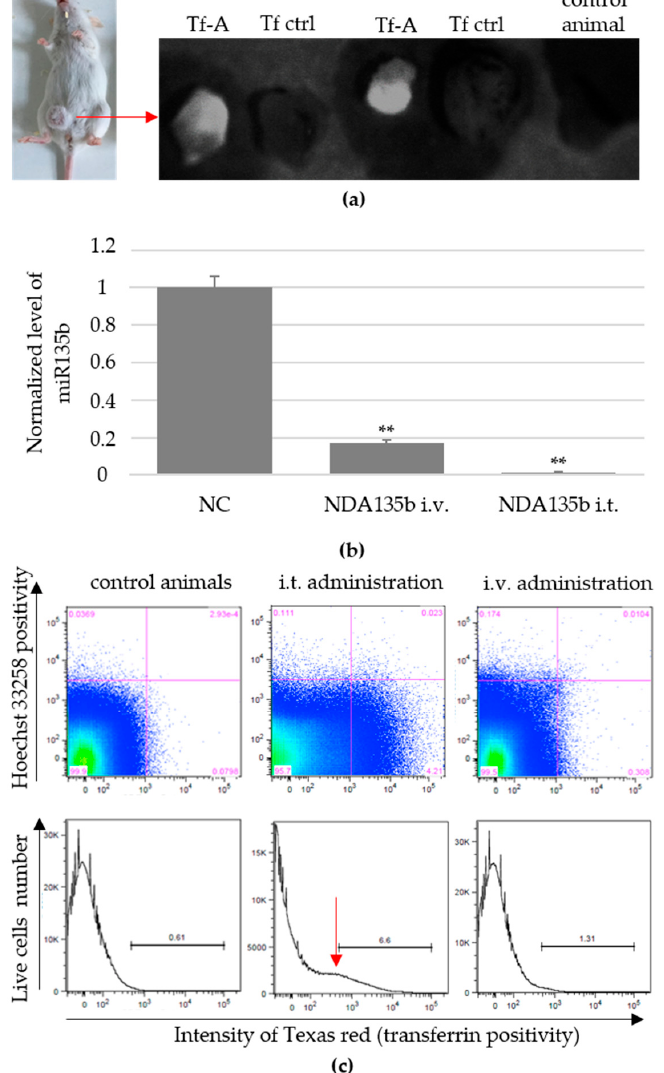
Figure 5. In vivo applications of NDA135b into breast tumor-bearing animals: ( a ) Detection of transferrin-Alexa Fluor 488 decorated NDA135b complexes (Tf-A) in tumor samples ex vivo. Tf ctrl stands for NDA135b decorated with Tf without the Alexa Fluor 488. Control animals received saline only; ( b ) detection of remaining miR-135b level in tumor after NDA135b administration. Data are presented as the mean ± standard deviation, ** p -value < 0.01 versus saline-treated group was obtained by ANOVA; ( c ) detection of NDA135b in cells obtained from excised tumors. Red arrow point to NDA135b-positive cells.